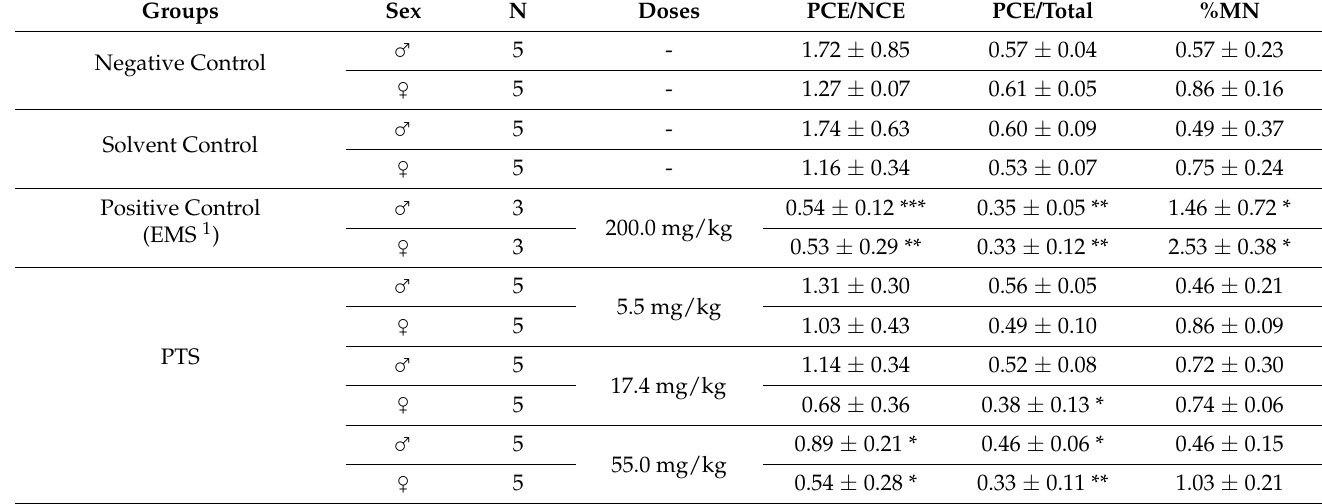
Table 1. Results of the micronucleus assay in rats exposed to PTS. Bone marrow cytotoxicity expressed as polychromatic erythrocytes (PCE) among total erythrocytes (normochromic erythrocytes (NCE) + PCE), ratio PCE among NCE, and the micronuclei induction expressed as % micronucleus (MN). Statistical analysis was performed using the analysis of variance (ANOVA) followed by Dunnett’s multiple comparison test. The values are expressed as the mean ± SD. Significant difference from the negative and solvent control (* p < 0.05; ** p < 0.01; *** p <